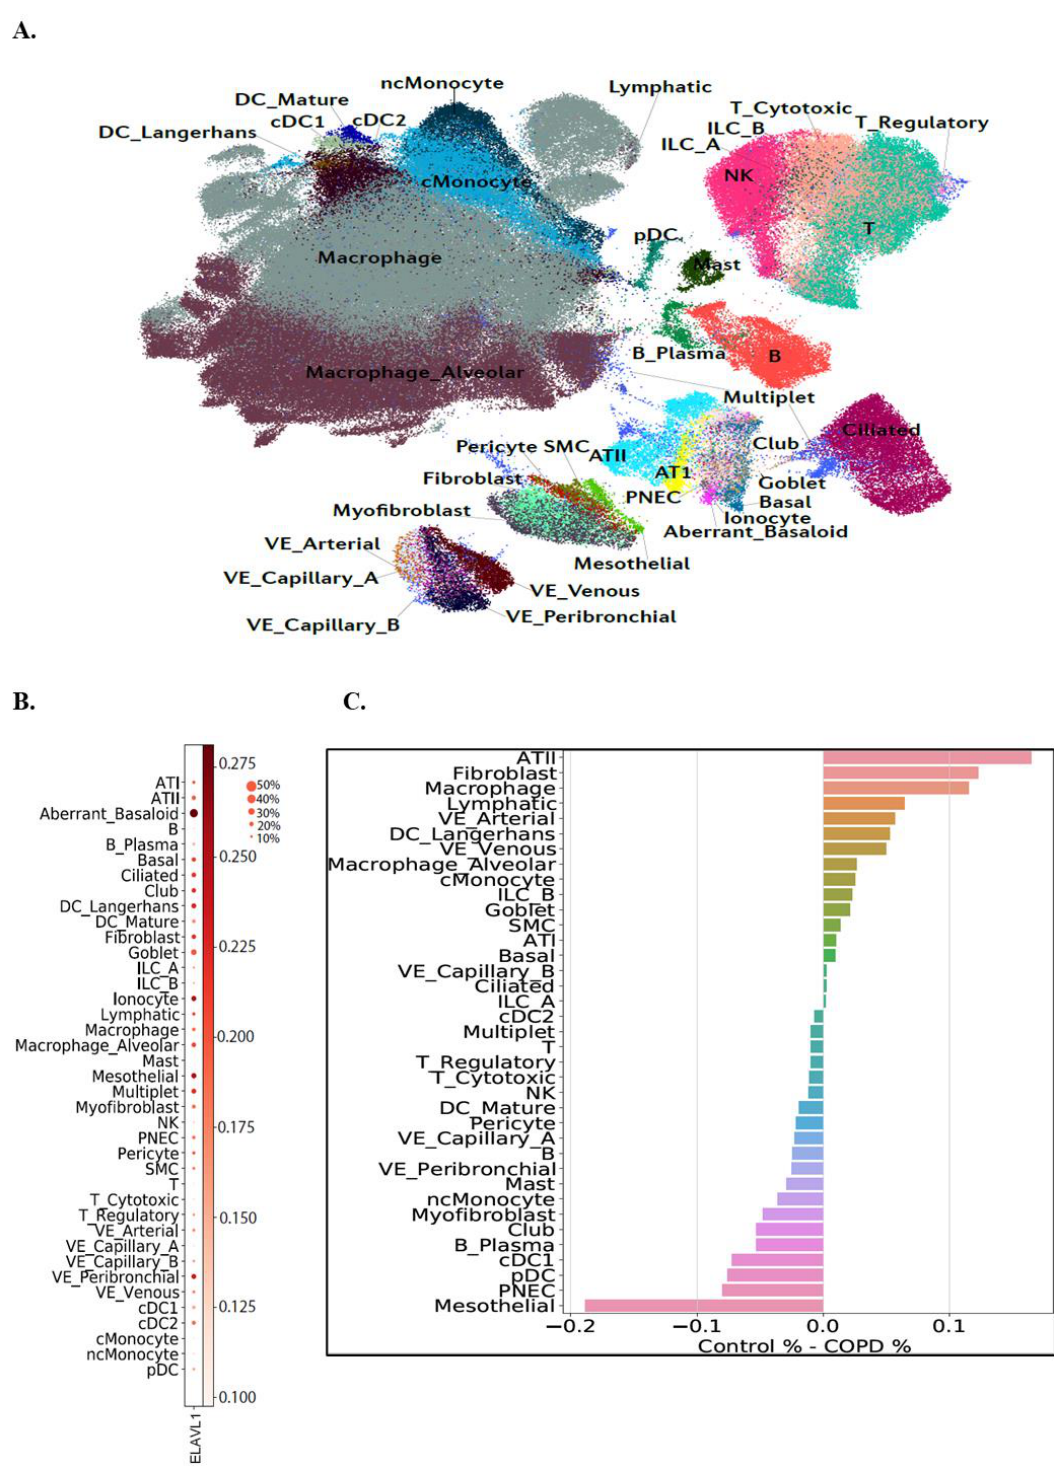
Figure 2. ELAVL1 single-cell level expression in COPD. ( A ) Different cell populations in the COPD single-cell RNA-seq data [29]. ( B ) Dotplot shows the expression of ELAVL1 in different cell popula- tions. The size of the circle denotes the % of cells expressing ELAVL1 . The darkness of the circle shows the expression level. Aberrant_basaloid, mesothelial, VE_peribronchial, PNEC, ciliated, and club cells are among the cell types with the highest expression of ELAVL1 . ( C ) Percentage of ELAVL1 + cells: on the right side (positive % difference) is the cell types with higher % of ELAVL1 + cells in control. On the left side are the cell types with higher % of ELAVL1 + cells in COPD (0.1 denotes